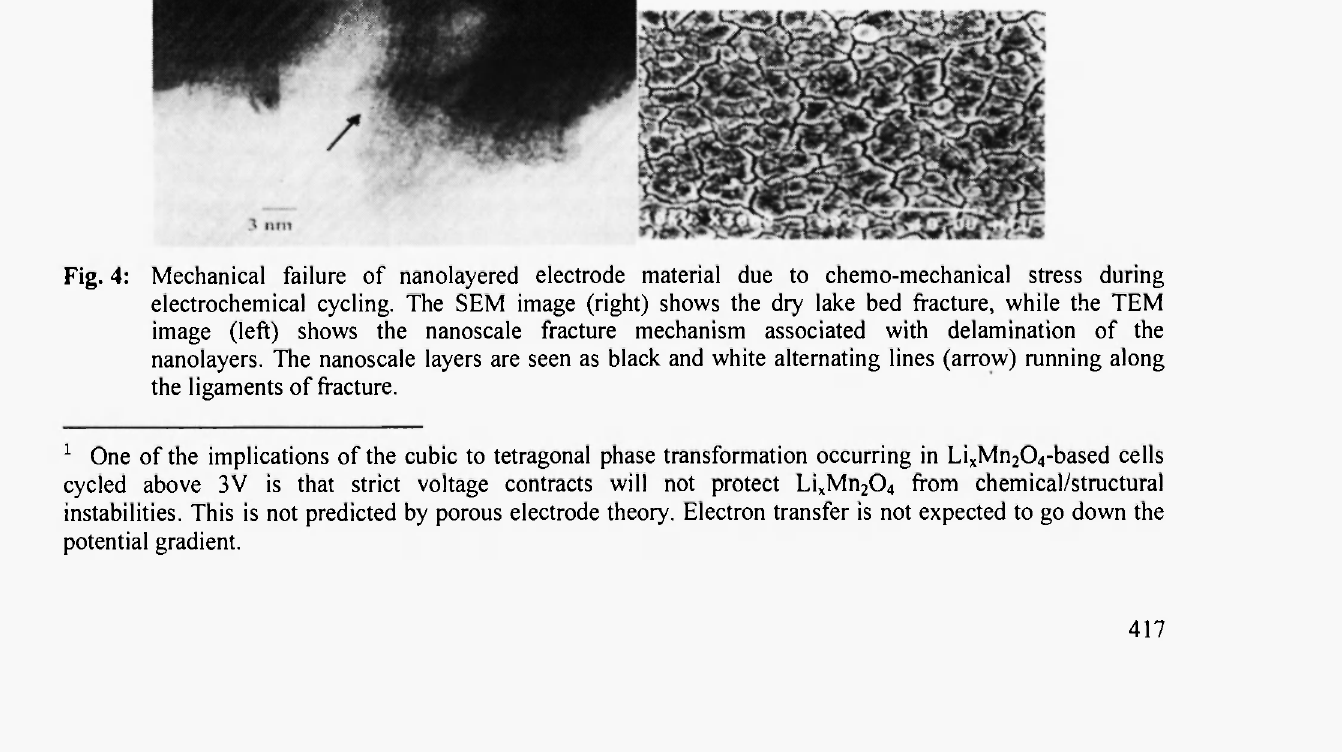
Fig. 4: Mechanical failure of nanolayered electrode material due to chemo-mechanical stress during electrochemical cycling. The SEM image (right) shows the dry lake bed fracture, while the TEM image (left) shows the nanoscale fracture mechanism associated with delamination of the nanolayers. The nanoscale layers are seen as black and white alternating lines (arrow) running along the ligaments of